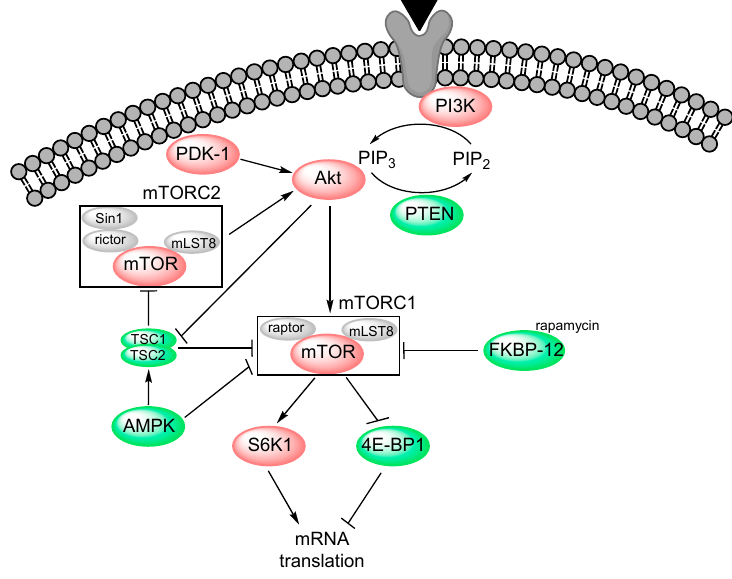
Figure 1. The PI3K-Akt-mTOR pathway. Signalling through this pathway can be initiated through growth factor ligation of specific receptors. PI3K is then activated which leads to formation of PIP3 that activates/phosphorylates Akt. PTEN has PI3K-opposing effect on the equilibrium between PIP2 and PIP3, thereby inhibiting activation of Akt and its downstream partners. Final activation of Akt is mediated by PDK-1 and mTORC2. mTORC1 is activated by Akt, and is inhibited by rapamycin, AMPK and the TSC1/TSC2 complex. Akt is a negative regulator of the latter. Green colour indicates inhibitory activity, red colour indicates activation of signalling through the pathway.